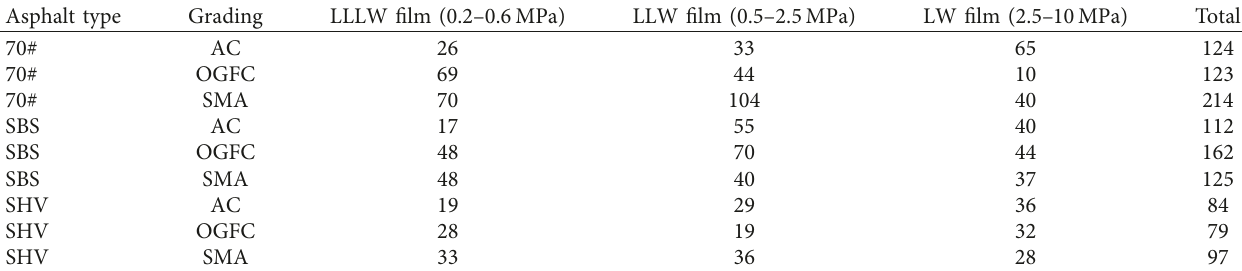
Figure 2: Contact stress information obtaining process. Table 7: Experimental load distribution results of pressure film